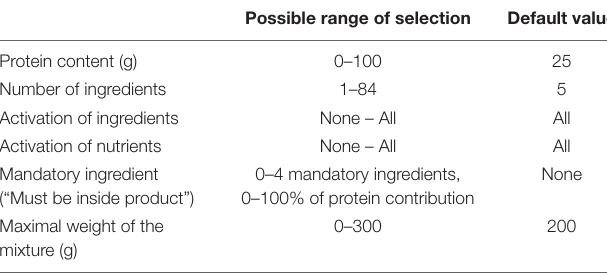
TABLE 1 | Customizable constraints of NutriOpt.